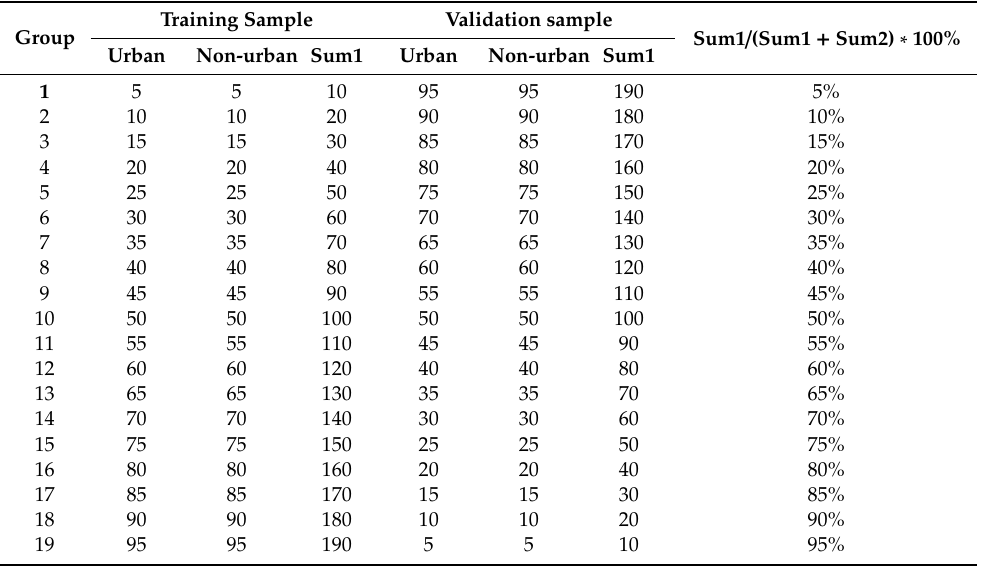
Table 3. Sample data set with di ff erent numbers of